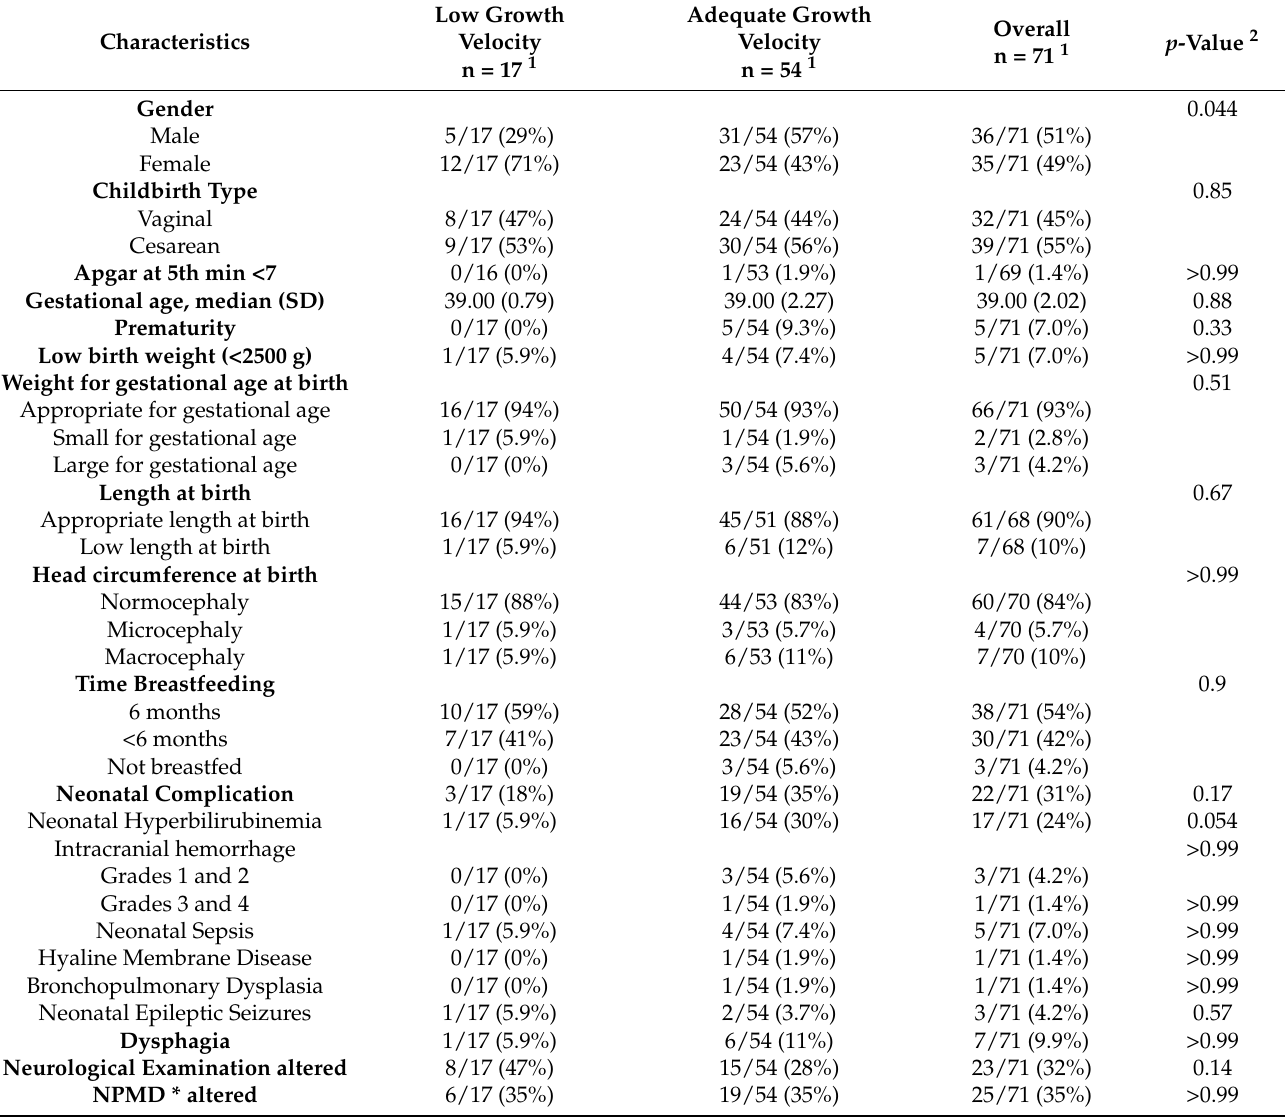
Table 2. Birth, neonatal, and postnatal clinical characteristics of children exposed in utero to the Zika virus, distributed according to the children’s growth velocity, Amazonas,